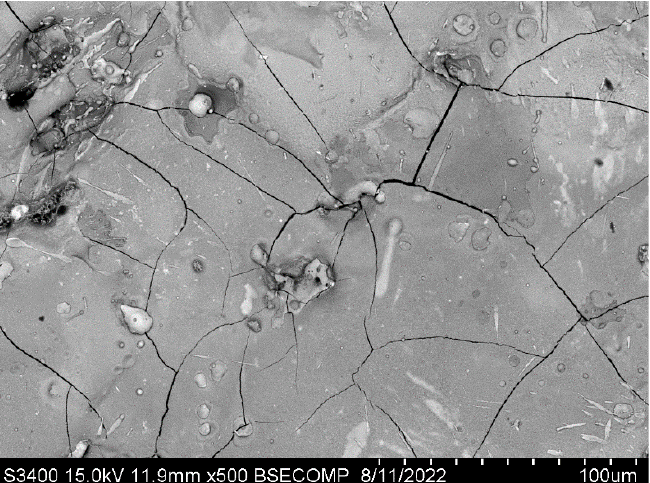
Figure 10. Top-view SEM image of the coating in the as-deposited state. Table 4. EDS data for different areas of the wear tracks (Figure 9). Hence, the dispersion-strengthened coating with the Laves phase as the predominant component had the lowest coefficient of friction (Kfr = 0.5) at T = 25 ◦ C, while at 700 ◦ C the lowest coefficient of friction (Kfr = 0.35) was observed for the substrate made of uncoated nickel alloy. At T = 25 ◦ C, the wear rate of the dispersion-strengthened coating was twice as low as that of the as-deposited coating and 20-fold lower than that of the uncoated